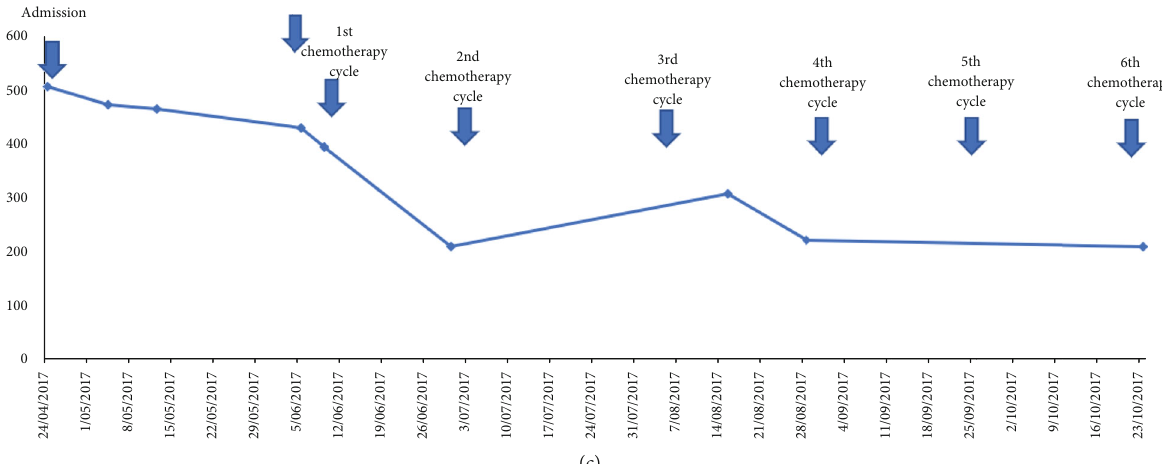
Figure 3: Evolution of the main laboratory parameters. The patient showed improvement in albumin, lactate dehydrogenase, and hemoglobin levels after the chemotherapy treatment. (a) The albumin levels of the patient showed improvement as a result of the treatment. (b) The hemoglobin levels show improvement as a result of the treatment. (c) The lactate dehydrogenase levels decreased as a result of the